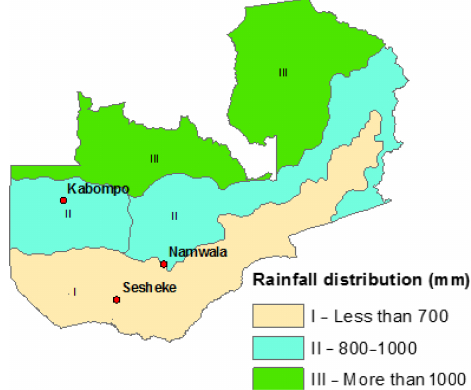
Figure 1. Distribution of rainfall and study sites following ecologi- cal zones I, II, and III (Sitwala Wamunyima, personal communica- tion,